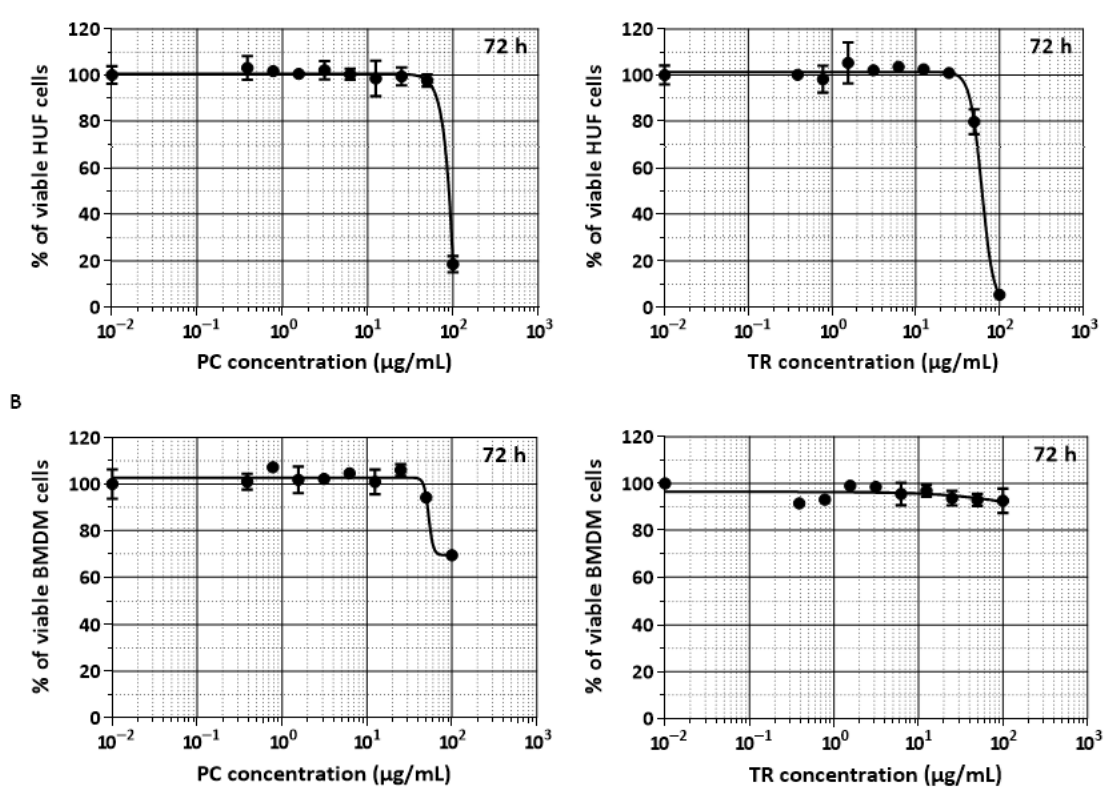
Figure 3. Effects of Pituranthos chloranthus (PC) and Teucrium ramosissimum Desf. (TR) extracts on normal primary human uterine fibroblast cells (HUF) and primary murine Bone Marrow-Derived Macrophages (BMDM) viability. After treatment of primary HUF and murine BMDM with increasing concentrations (0–100 µ g/mL) of PC and TR for 72 h, the percentage of viable cells was assessed using the (3-(4,5-dimethylthiazol-2-yl)-2,5-diphenyltetrazolium bromide (MTT) assay. ( A ) Dose–response curves of PC-treated HUF (left panel) and TR-treated HUF (right panel). ( B ) Dose–response curves of PC-treated BMDM (left panel) and TR-treated BMDM (right panel). Data are expressed as a mean percentage of control growth ± Standard Deviation (SD) of two representative experiments ( n = 6 replicates per concentration).